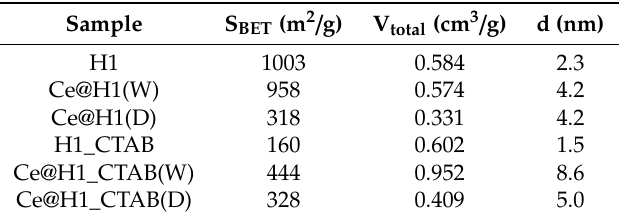
Figure 2. N 2 adsorption–desorption isotherms at standard temperature and pressure (STP) for HKUST-1 and Ce@HKUST-1 materials. “Ads”—adsorption, “des”—desorption. Table 2. Textural properties of HKUST-1 and Ce@HKUST-1 materials: specific surface area (S BET ), total pore volume (V total ), and mean pore size